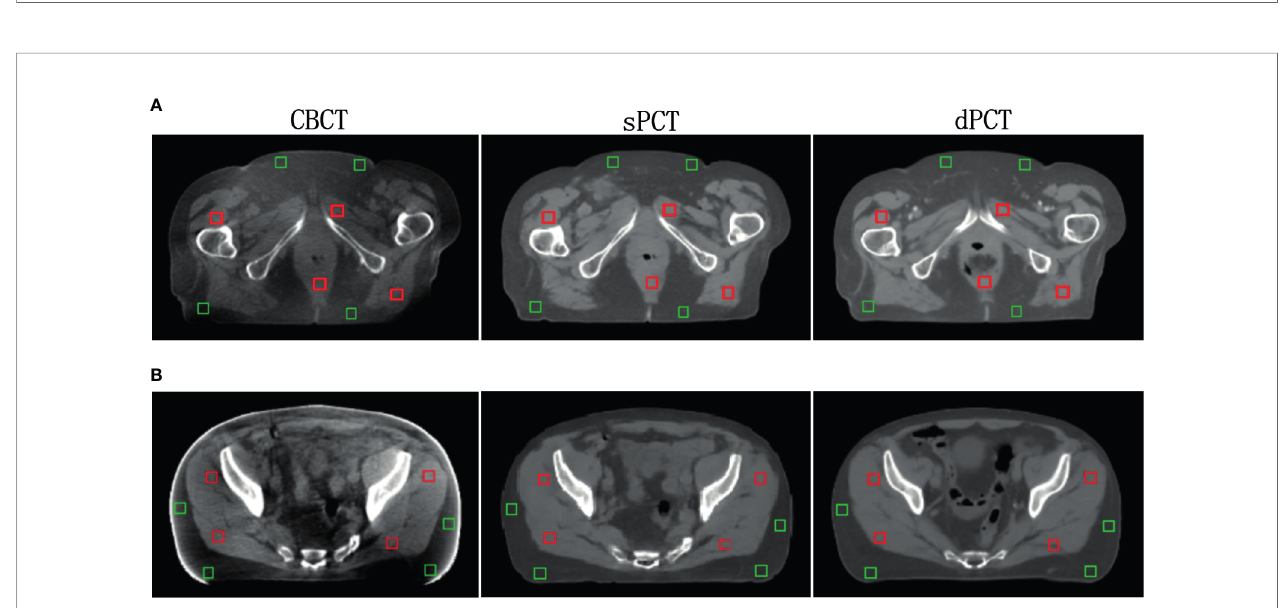
FIGURE 8 | HU histograms of CBCT, sPCT, and dPCT respectively. The left and right images represent two patients (A, B) . For each patient, it displays the histogram of CBCT, dPCT, and sPCT images between 200HU and 1200HU.